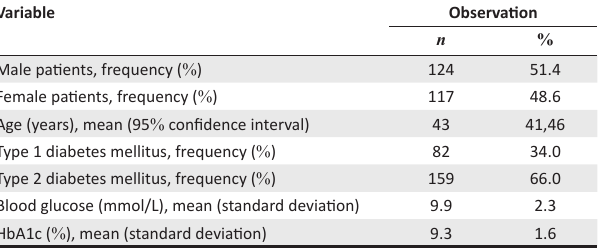
TABLE 1: Characteristics of the study participants at enrolment ( N = 241), Kampala, Uganda, March 2017 to December 2017. Variable